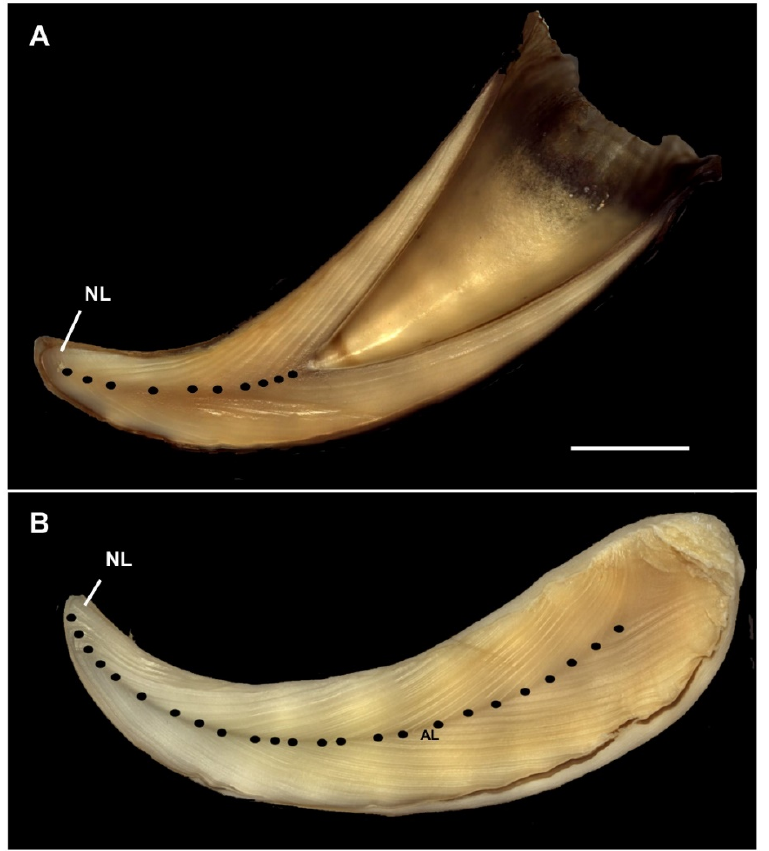
Figure 1. Representative composite photographs of sperm whale longitudinal, acid-etched, tooth sections. ( A ) ID 456, male, with number of GLGs estimated as 10. ( B ) ID 549, female, with number of GLGs estimated as 24–26. The filled circle indicates the start of each GLG. NL: neonatal line. AL: accessory line. Scale bar:1.5 cm in ( A ) e 1.4 cm in ( B ). Table 3. ID number, sex, total body length (TBL) and age of P. macrocephalus specimens examined in this study. ND: undetermined sex.